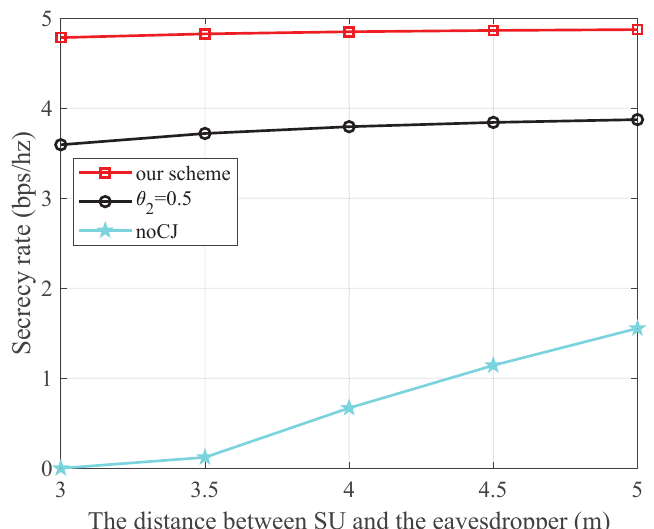
Figure 5. The secrecy rate versus the distance between SU and the eavesdropper.